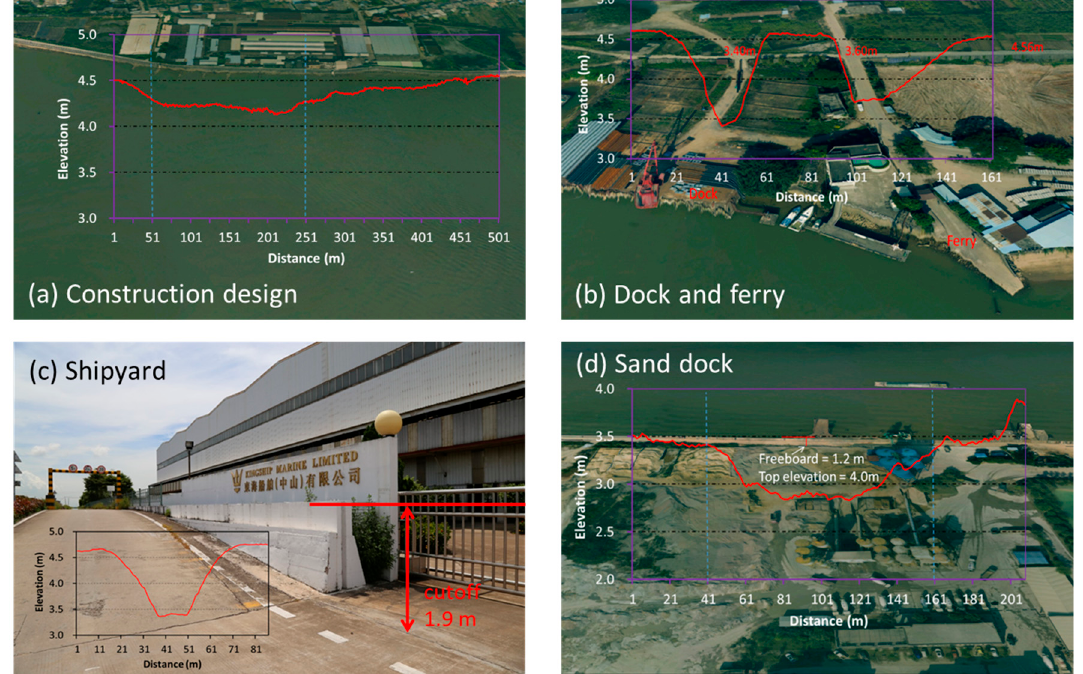
Figure 10. Examples of levee modifications and traffic notches of ( a ) construction design, ( b ) dock and ferry, ( c ) shipyard in levee A, and ( d ) sand dock in levee C. The inset plots are the surface elevation over the levee modification marked as ① to ④ in Figures 8,9. The plot range is adjusted to match the horizontal size of levee modification in plots (a), (b) and (d).